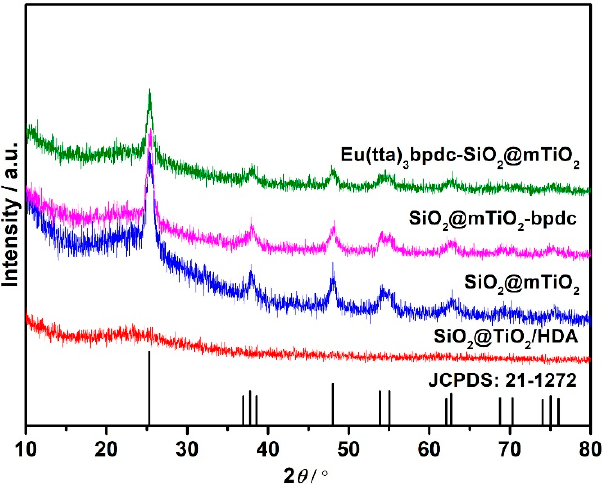
Figure 2. The PXRD patterns of SiO 2 @TiO 2 /HDA, SiO 2 @mTiO 2 , SiO 2 @mTiO 2 -bpdc and Eu(tta) 3 bpdc-